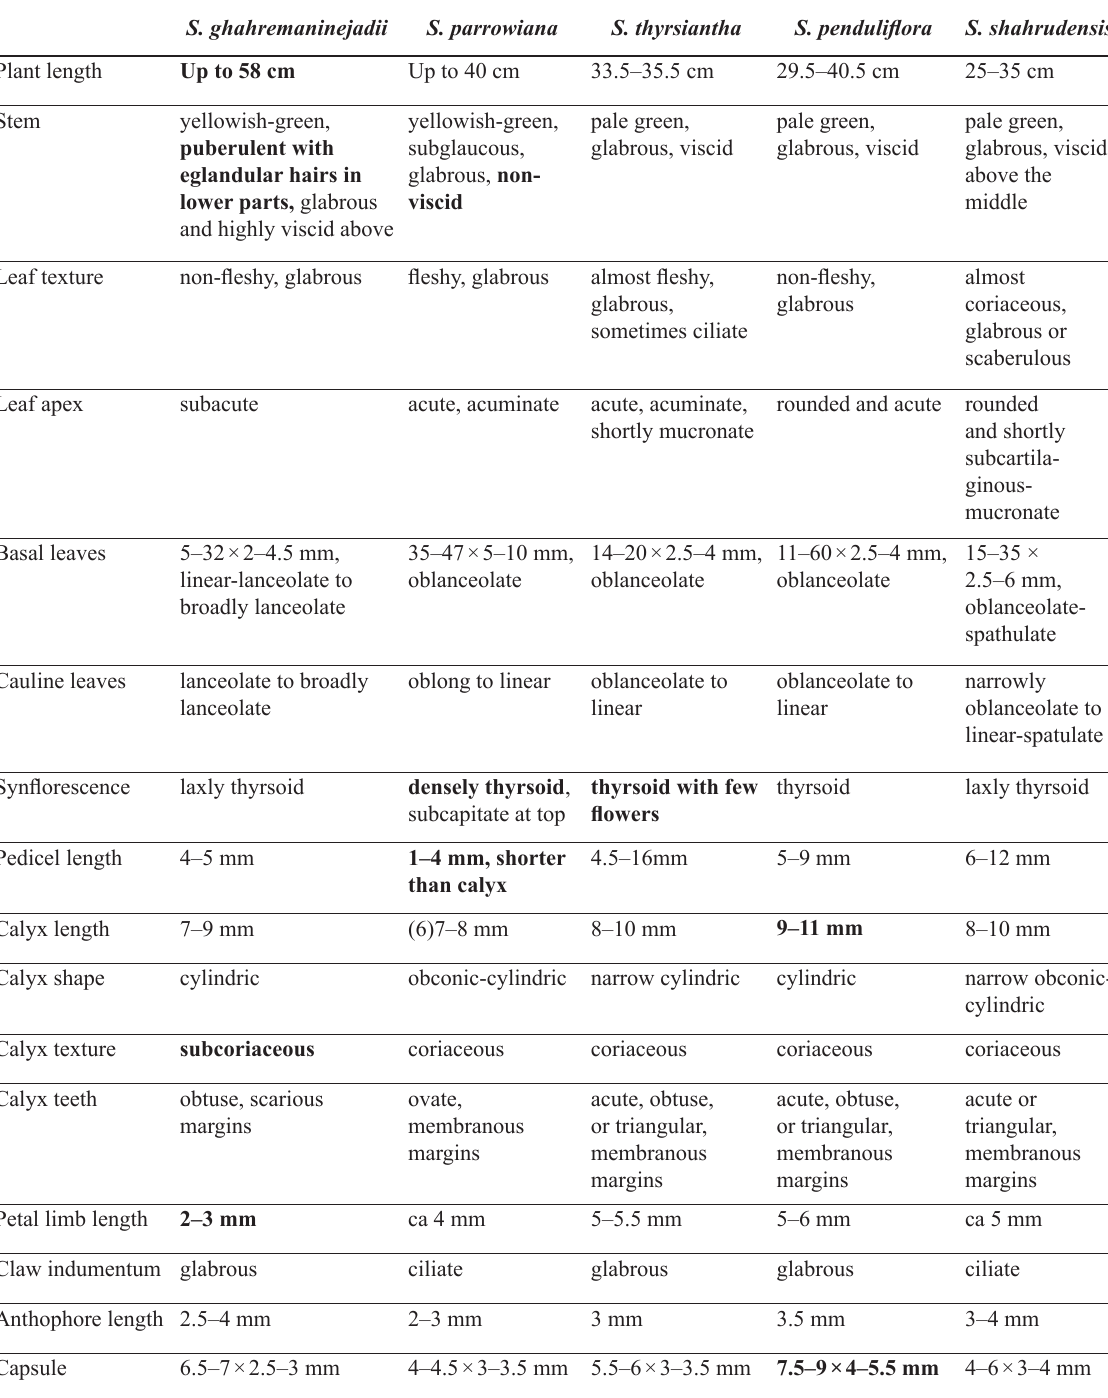
Table 1. Morphological comparison among S. penduliflora F.Jafari, Keshavarzi & Doostm. sp. nov., S. thyrsiantha F.Jafari, Mirtadz. & Keshavarzi sp. nov. and close relatives. Distinctive character states are shown in